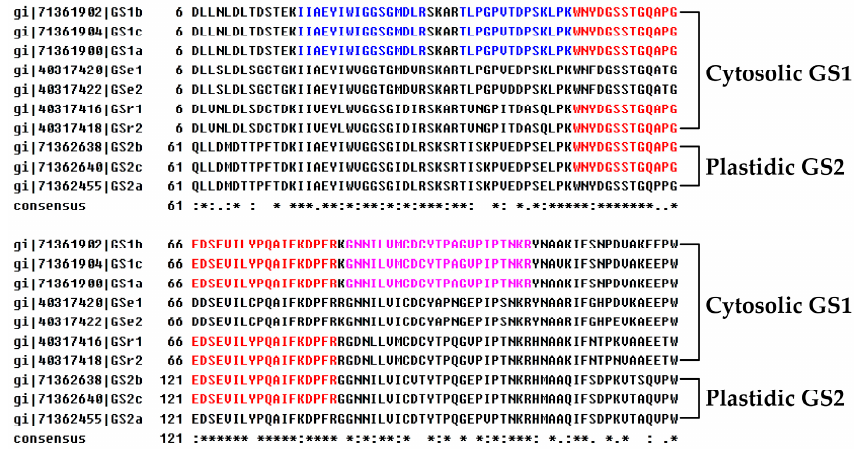
Figure 7. Sequence alignment between the mass spectrometry (MS)-identified peptides from two proteoforms of glutamine synthetase 1 (GS1) (spots 795 and 806) and the amino acid sequences of the ten GS isozymes in wheat ( Triticum aestivum L.). The amino acid sequences from wheat used for the multiple sequence alignment were from National Center for Biotechnology Information non-redundant (NCBInr) protein database and submitted by Bernard et al. [36]. The accession numbers and names of the GS isozymes were listed on the left, and the subfamilies were shown on the right of the amino acid sequences. The asterisk indicates completely conserved residues; colon indicates highly conserved residues; dot indicates a weak conservative region. The MS-identified peptides from spots 795, 806 and both were highlighted in red, blue, and purple fonts, respectively. The results showed that the MS-identified peptides were well aligned with cytosolic GS1, but not plastidic GS2. The detailed information of the identified peptides can be found in Table S1, and the complete alignment can be found in Figure S3.